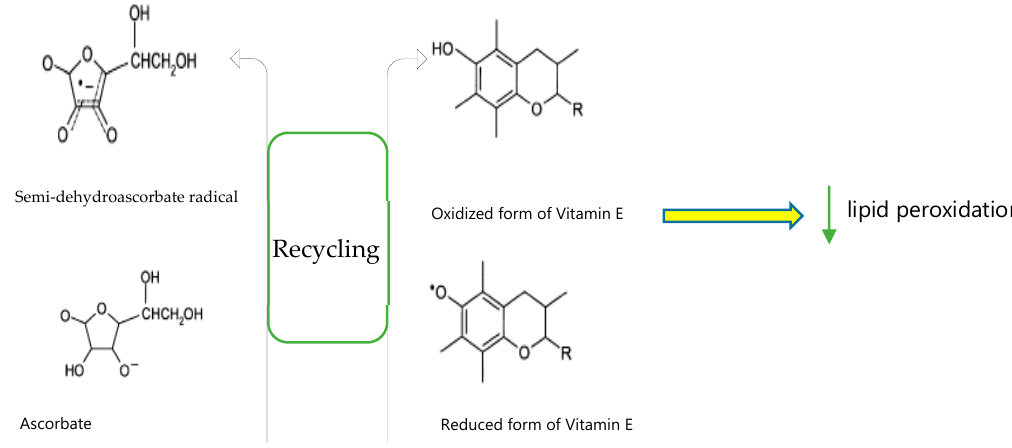
Figure 1. Vitamin C acting as a reducing agent to recycle vitamin E to protect against lipid peroxidation.